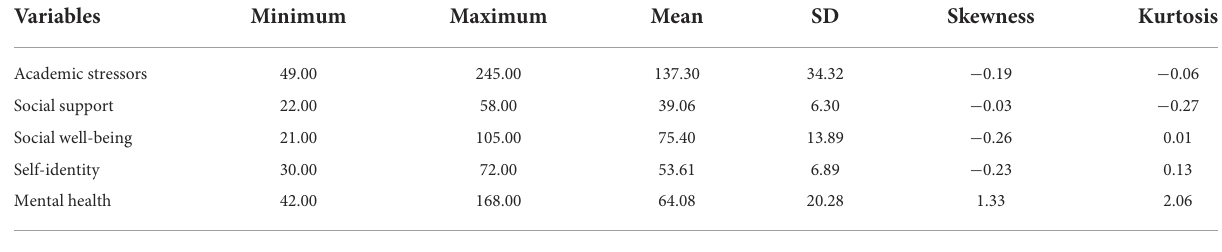
TABLE 1 Descriptive statistics for main variables.